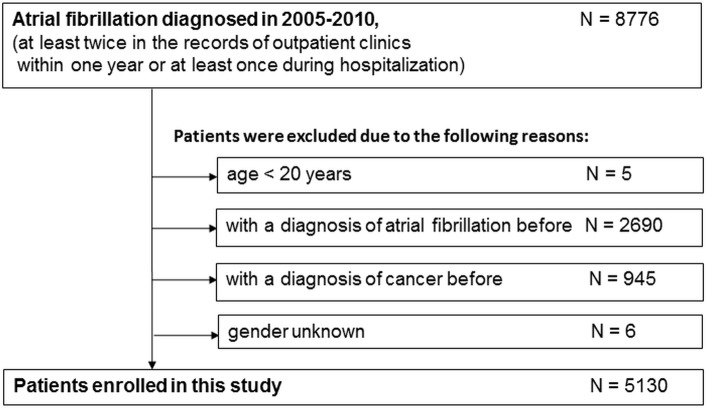
Diagram of patient flow.